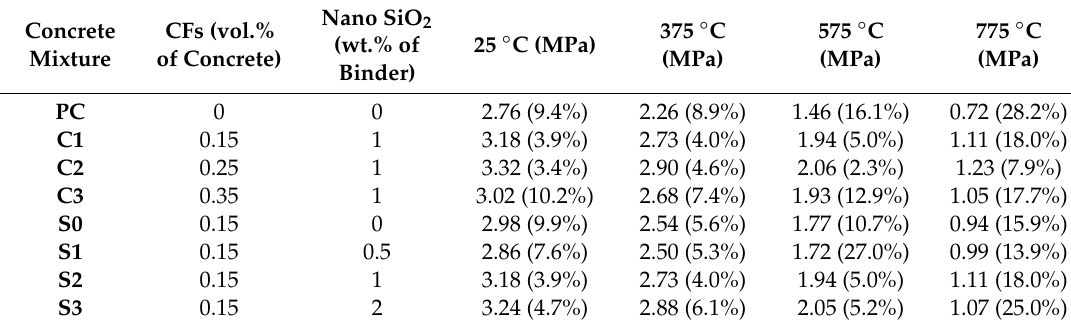
Table 5. Splitting tensile strength of di ff erent NSCFRC after